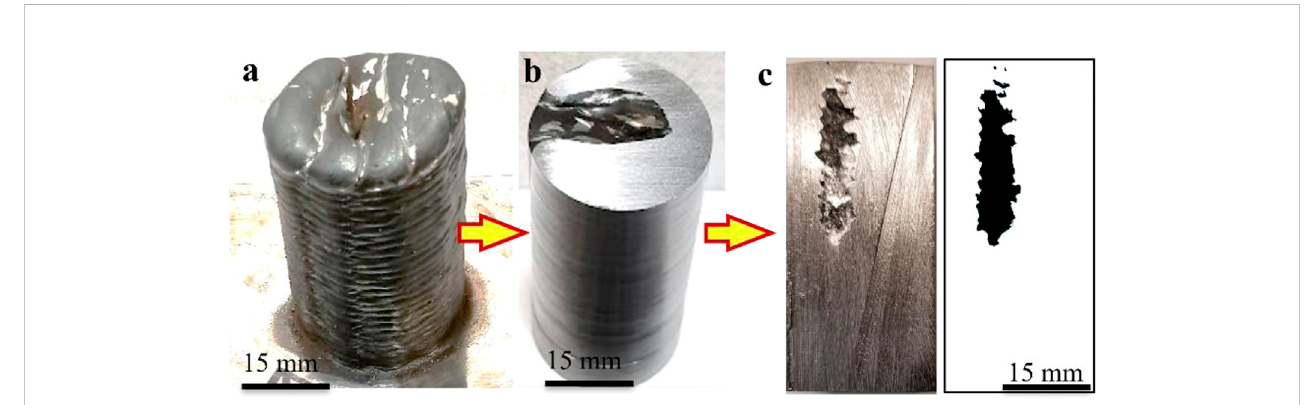
FIGURE 4 (A) WAAM printed cylinder without active cooling; (B) cylinder after the turning operation and (C) after longitudinal sectioning. A binary image was used for defect surface area analysis.